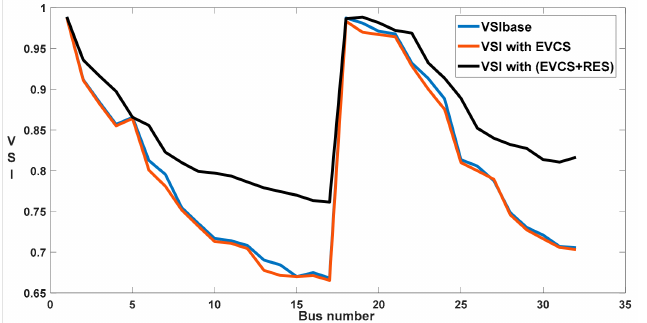
Figure 6. VSI of modified IEEE 33-bus